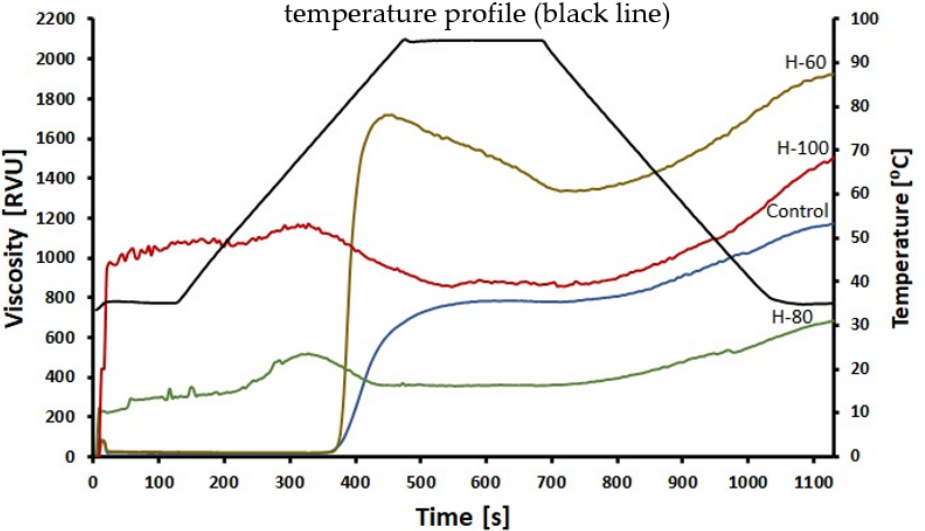
Figure 3. Pasting curve of native adlay flour (H-0) and pre-gelatinized adlay flours prepared at different temperatures (60 °C (H-60), 80 °C (H-80), and 100 °C (H-100)).